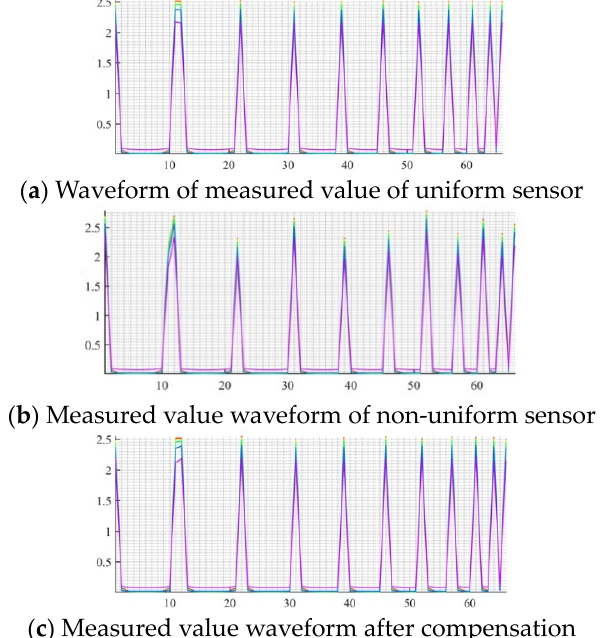
Figure 4. Schematic diagram of simulation object field setting of heterogeneous ECT sensor.